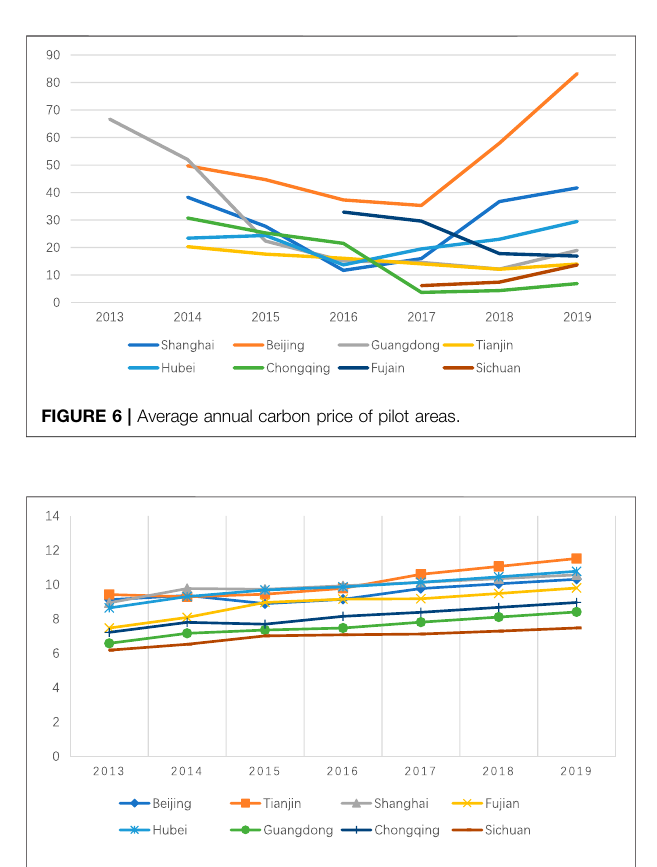
FIGURE 7 | Marketization index of pilot